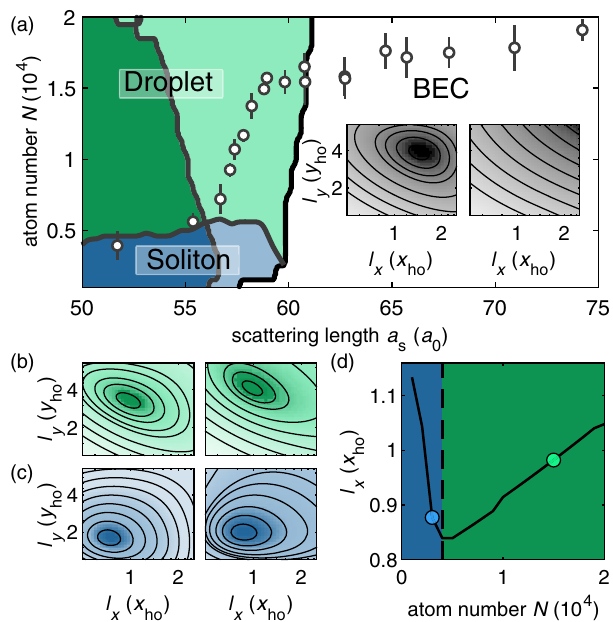
Fig. 4 Phase diagram and energy landscapes. a Phase diagram as a function of a s and atom number. The white region denotes a trap-bound BEC extended over several lattice sites. The colored regions denote quasi- 2D self-bound solutions: a droplet (green), a soliton (blue), each either extended over several lattice sites (lighter shade) or localized (darker shade, >95% of the atoms are localized in the central lattice plane). Circles show the atom number from our experimental data points in Fig. 3a. The statistical uncertainties on the scattering length is smaller than the symbols size. a – c Energy landscapes as a function of the radial widths l x and l y , in units of the radial harmonic oscillator lengths x ho = 0.50(1) μ m and y ho = 1.42(1) μ m, respectively, with (left) and without (right) the radial harmonic trap, for ( a ) BEC ( a s , N ) = (70 a 0 , 1.5 × 10 4 ), ( b ) droplet ( a s , N ) = (65 a 0 , 1.5 × 10 4 ) and ( c ) soliton ( a s , N ) = (51.5 a 0 , 0.4 × 10 4 ) regimes, with darker shading at the minima. d Radial width l x versus N for a s = 51.5 a 0 . The dashed line indicates the soliton-to-droplet transition point, and the circles indicate the position of b , c